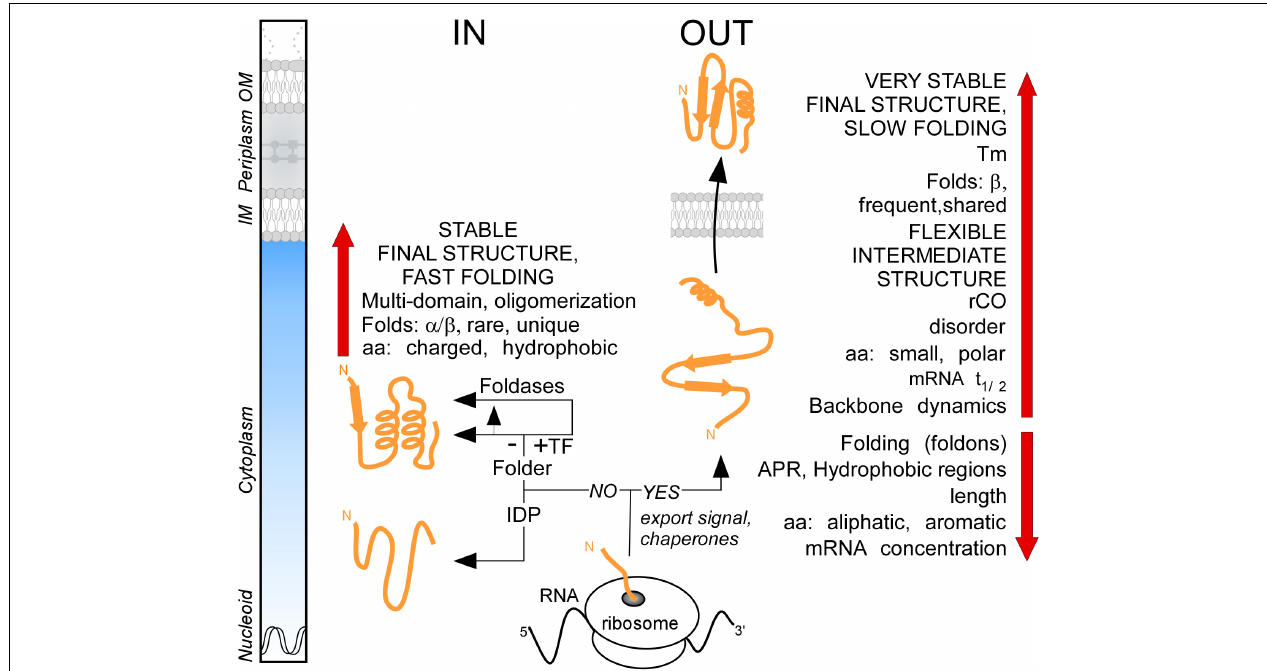
FIGURE 8 | Summary. Cartoon representation of protein synthesis and folding at final destinations in K-12 (IN: Cytoplasmome; OUT: Secretome). Important factors and check-points influencing this process are summarized. See text for details. aa, amino acids; APR, aggregation prone region; IDP, intrinsically disordered protein; IM, inner membrane; OM, outer membrane; rCO, relative contact order; TF, trigger factor; Tm, melting temperature.